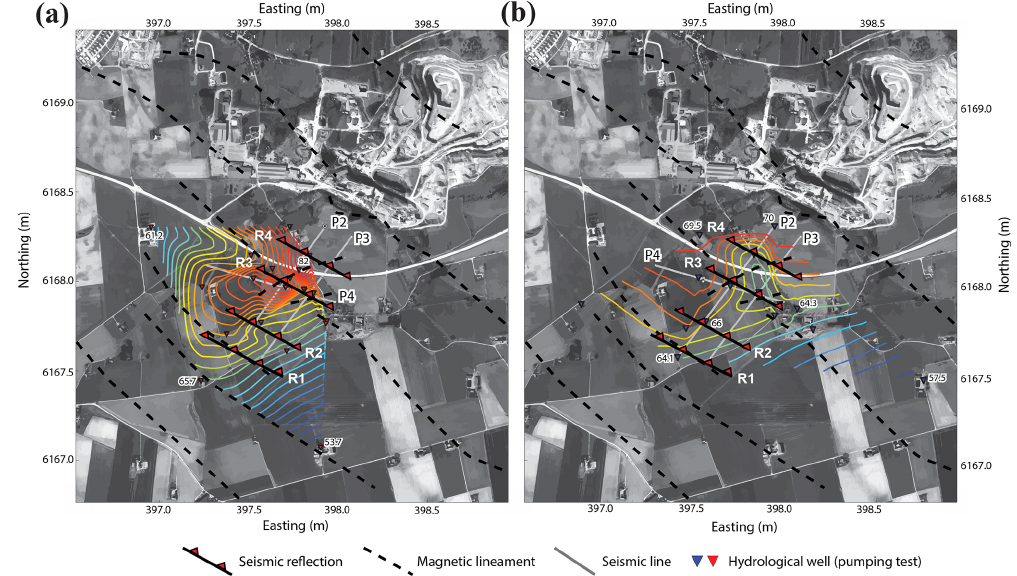
Figure 14. Hydrological measurements conducted at the site to better understand groundwater flow in (a) sediments and (b) bedrock, and if they can be connected to any underlying geology controlling their patterns. Red contours indicate high water table values and blue lower water table values. Water table values (ranging from 53 to 82m elevation) are shown at a few places. The reflections observed in the seismic data are labeled as R1–R4. In the case of bedrock, a clear NW–SE groundwater flow is notable in the region where R1–R2 are observed, which may indicate the role of the steeply dipping dykes in this region. Dashed lines are the peaks of the magnetic lineaments extracted from the aeromagnetic data (Fig. 1a) from the study area. We interpret a local fault running near and parallel to profile 2 and responsible for the NE–SW trend of the water flow in the bedrock between reflections R3 and R4.